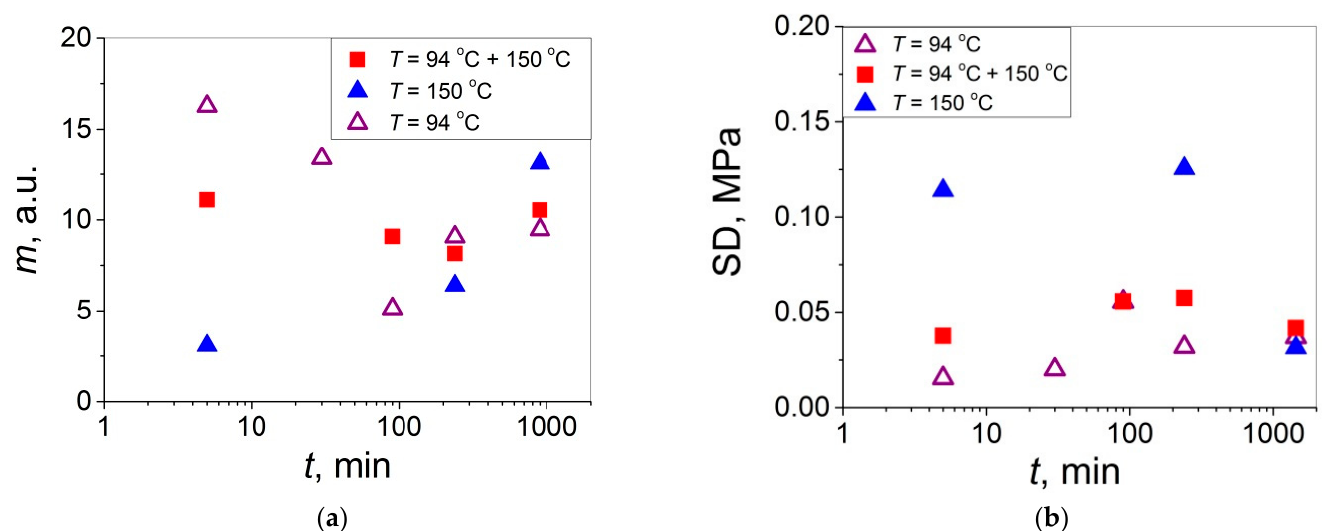
Figure 14. ( a ) Weibull’s modulus m and ( b ) standard deviation SD as a function of the healing time t for initially amorphous symmetric PET–PET interfaces self-healed: (open triangles) at T = 94 °C, (solid squares) self-healed at T = 94 °C and thereafter at T = 150 °C for 5 min, and (solid triangles) submitted to self-healing at T = 150 °C.